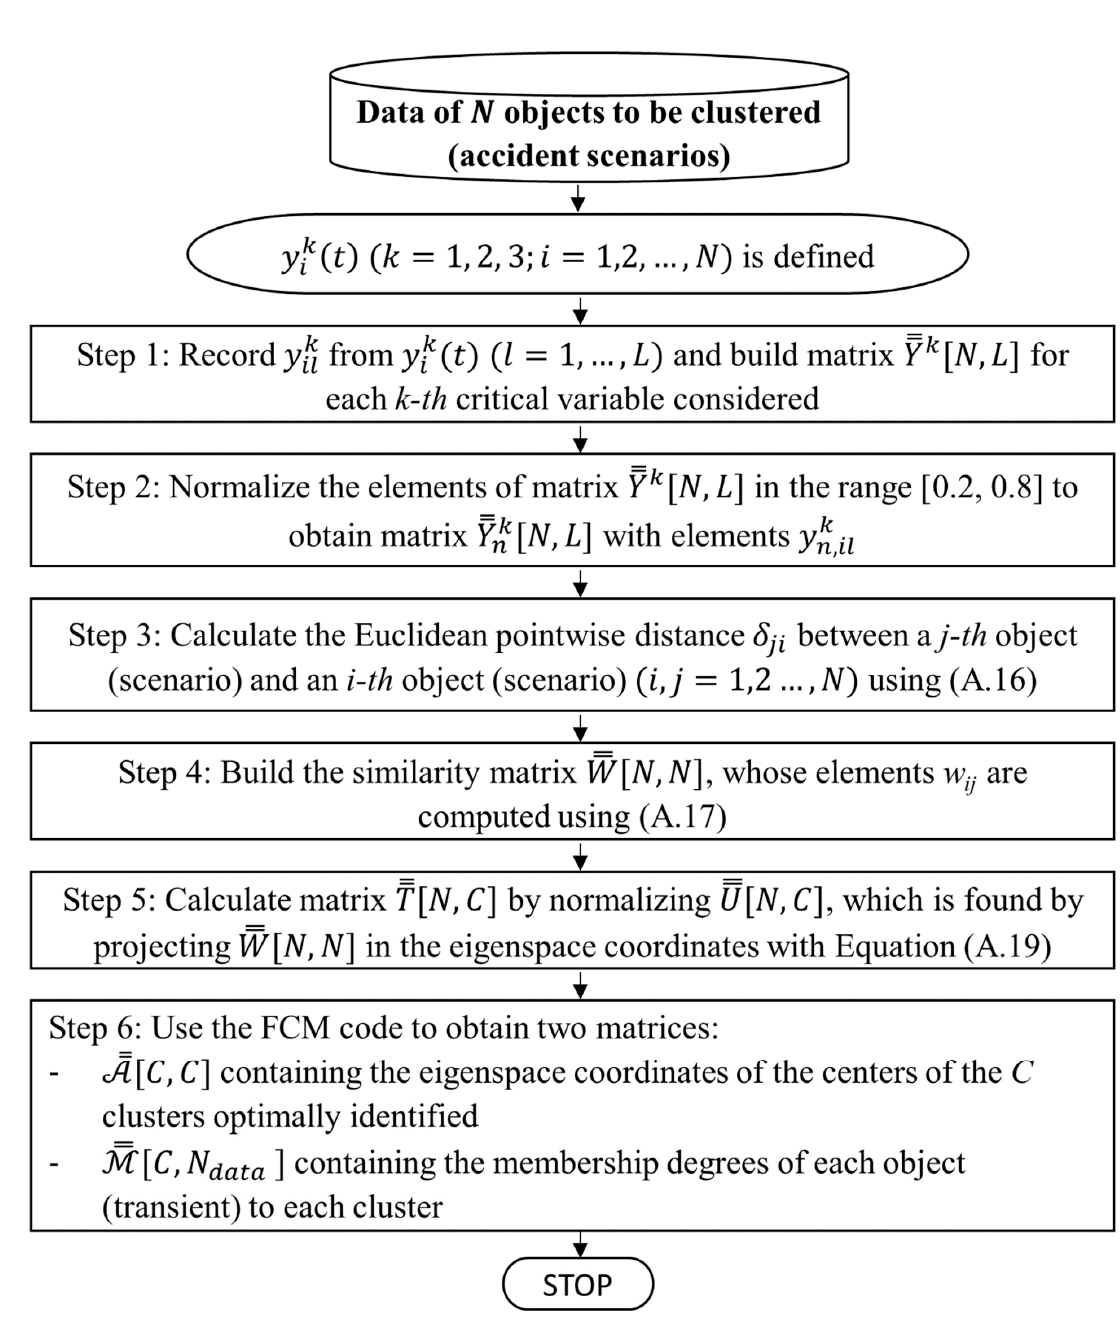
Figure A1. Flowchart of the Spectral Clustering (SC) embedding the Fuzzy C-Means (FCM).